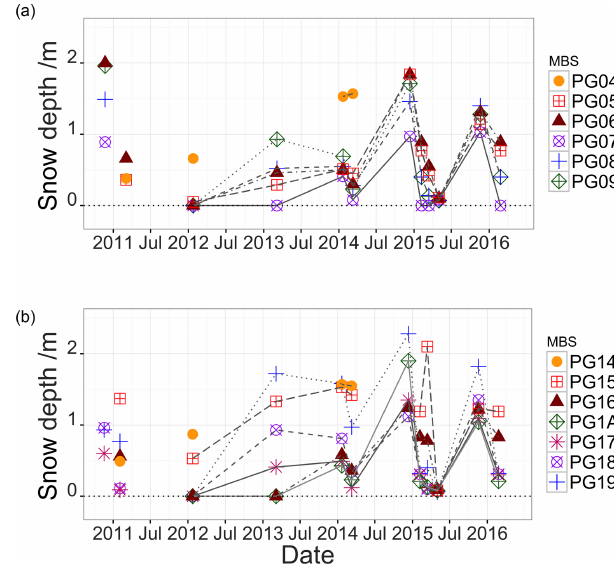
Figure 7. (a) Time series of snow depth measured at the two mass balance stake transects (PG0 x and PG1 x ) on the Fourcade Glacier, Potter Peninsula, during the time period November 2011 to May 2016. (b) Snow depth profile with elevation measured during summer and late fall 21 January and 10 March 2014. The location of the individual mass balance stakes (MBS) is shown in Fig. 1. The snow density and snow depth time series were